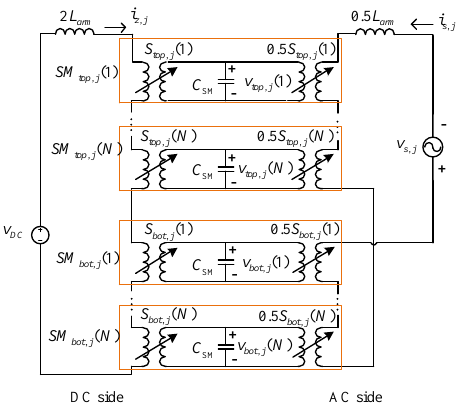
Figure 2. Equivalent circuit of single MMC phase.